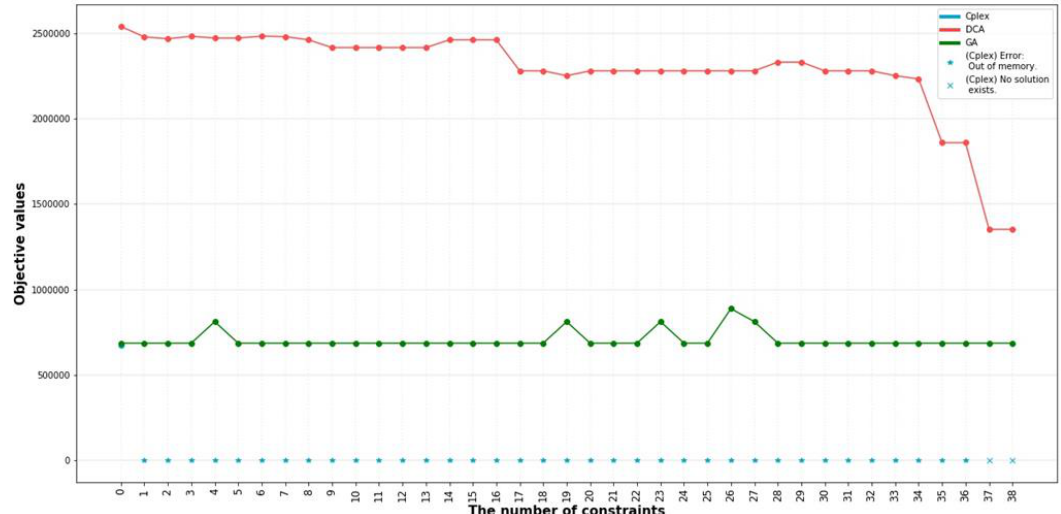
Figure 11. The objective value of three tested algorithms to find a team of three members from 3728 candidates.